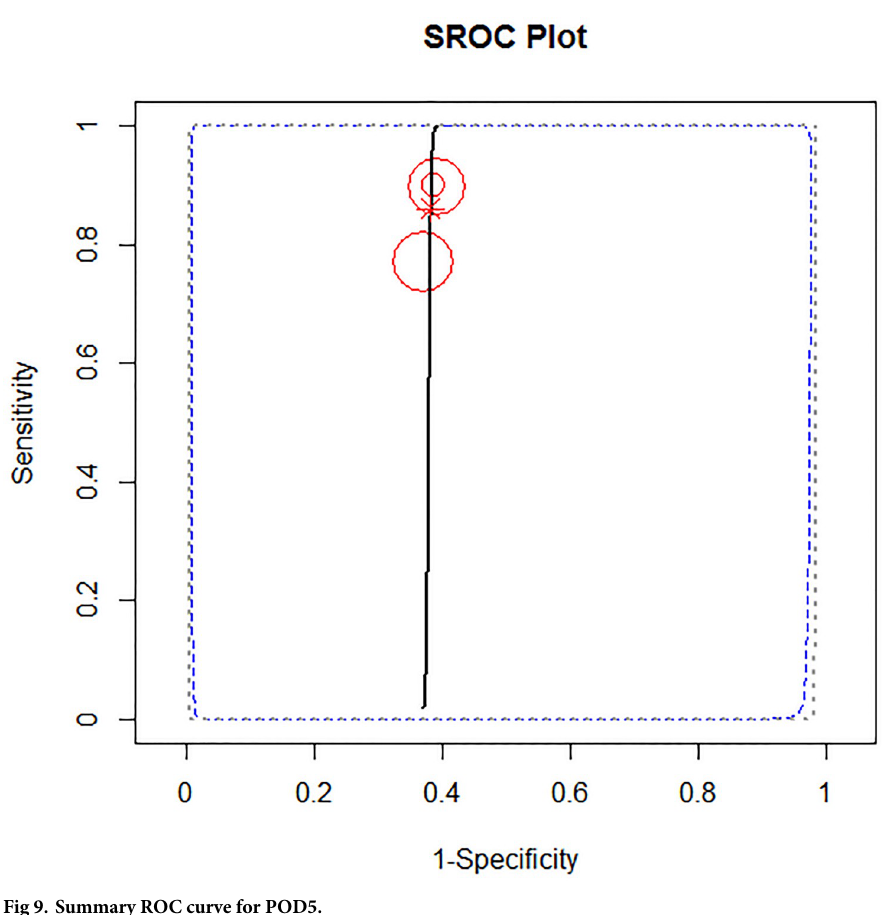
Fig 9. Summary ROC curve for POD5.